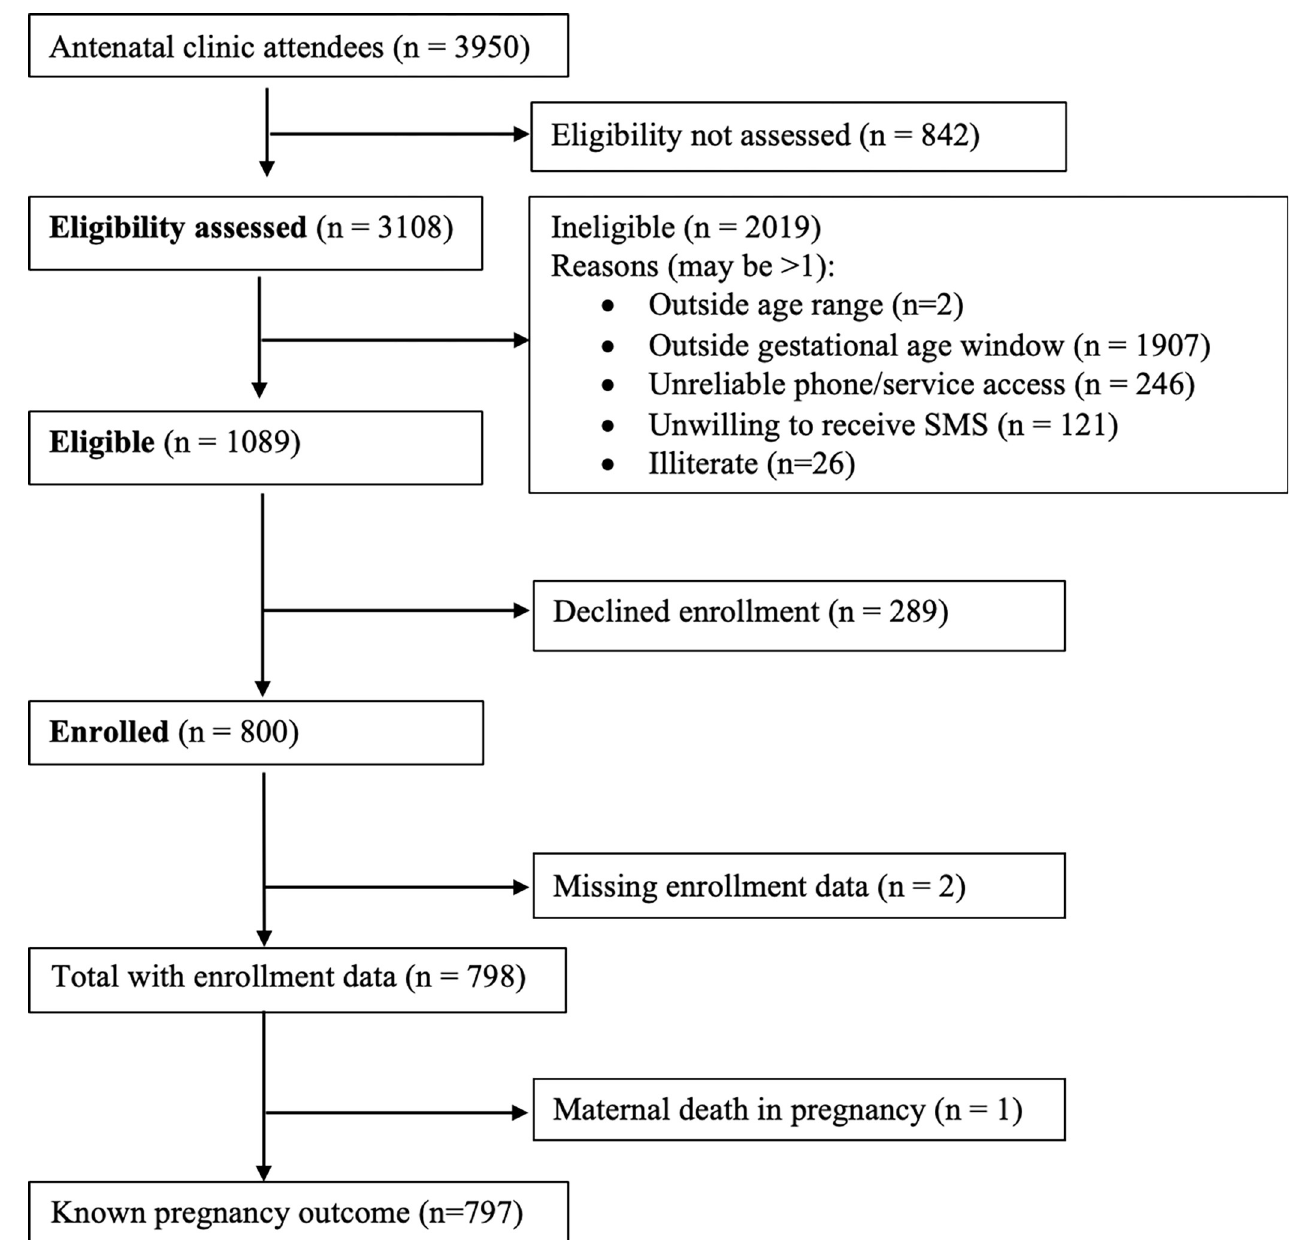
Fig 1. Diagram of recruitment and enrollment of study participants. ANC = antenatal care. EDD = estimated due